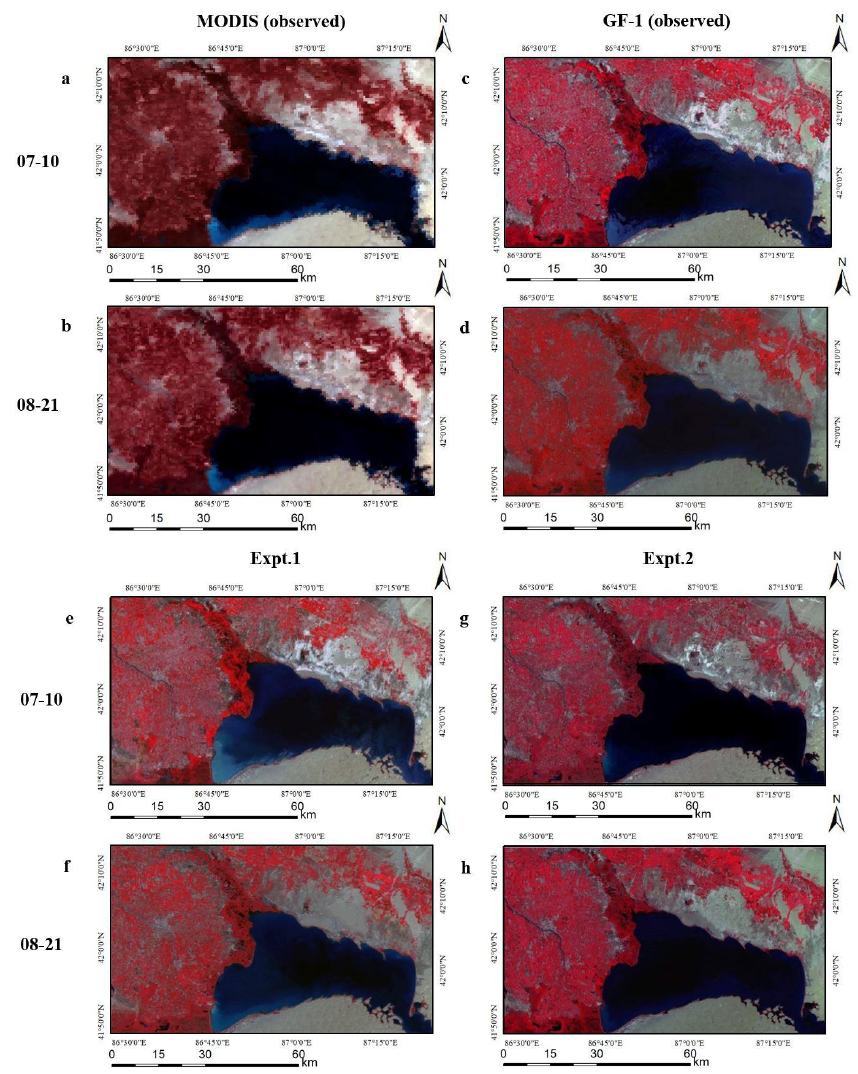
Figure 6. The real and predicted images (NIR–red–green). ( a , c , e , g ) show the MODIS true image, the GF-1 WFV true image, the predicted image of Expt.1, and the predicted image of Expt.2, respectively, on 10 July; ( b , d , f , h ) show the MODIS true image, the GF-1 WFV true image, the predicted image of Expt.1, and the predicted image of Expt.2, respectively, on 21